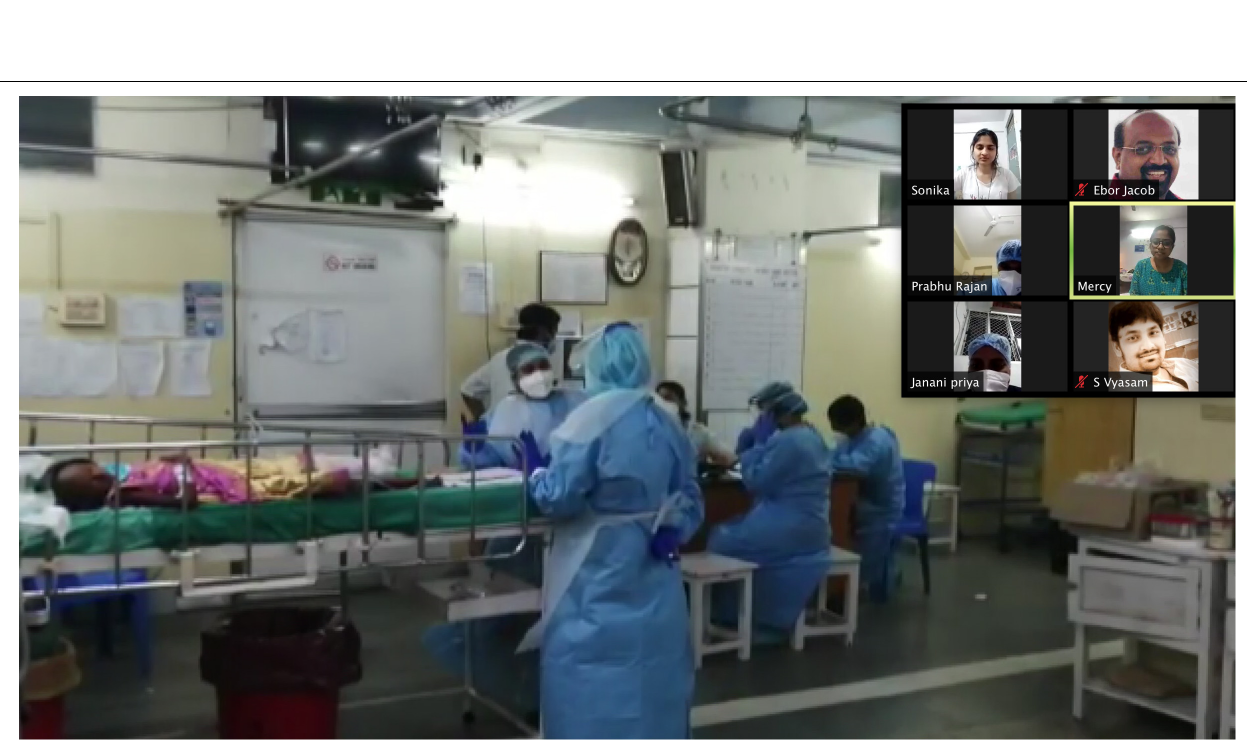
Frontiers in Pediatrics |